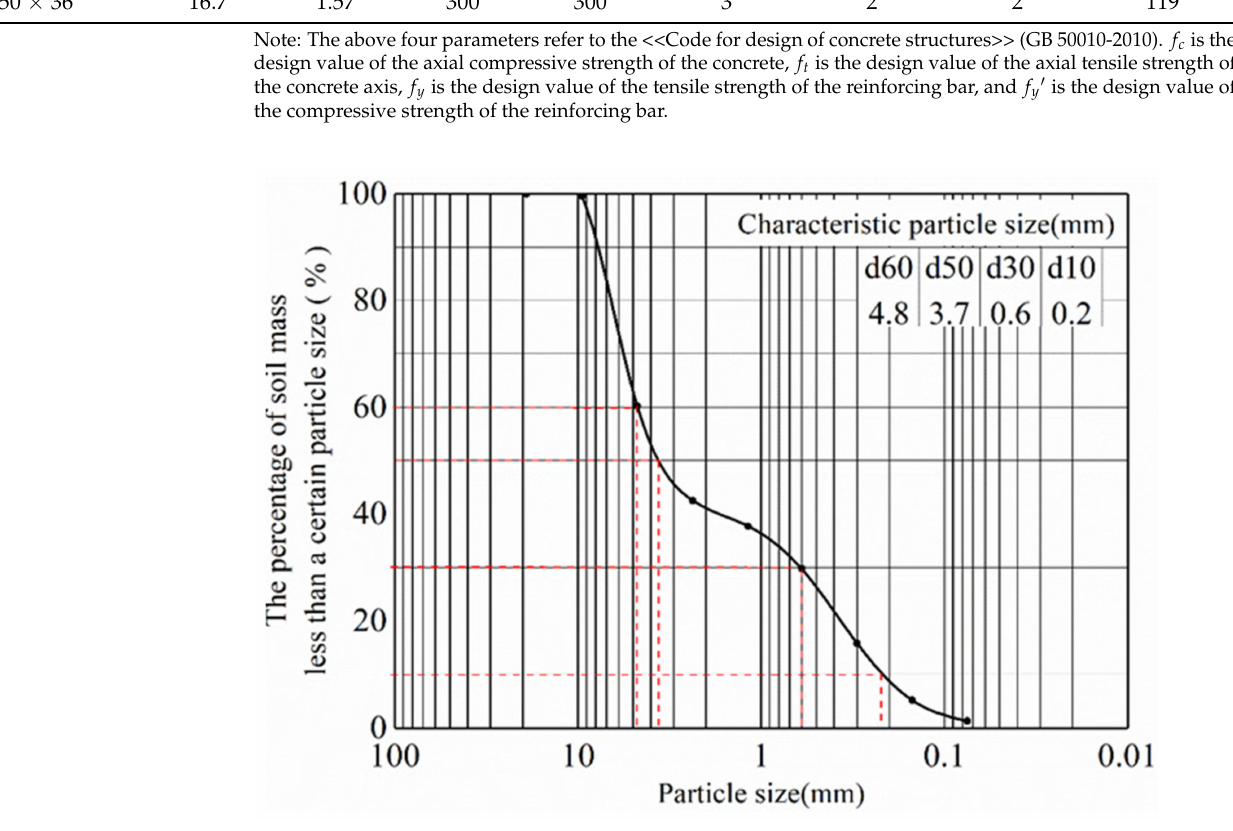
Figure 2. Sliding mass